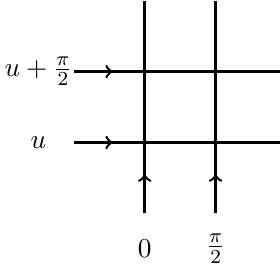
Figure 4 . The block R